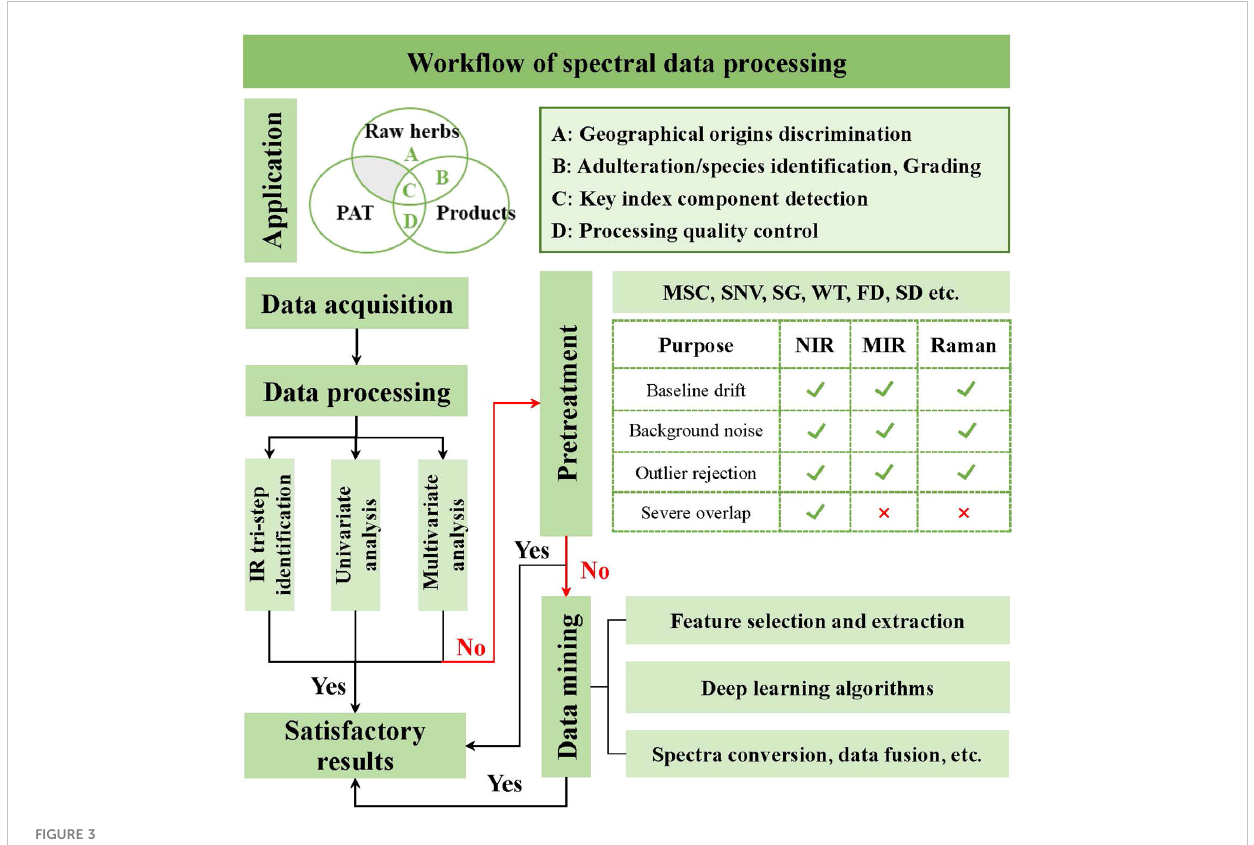
FIGURE 3 The rough schematic diagram of spectral data